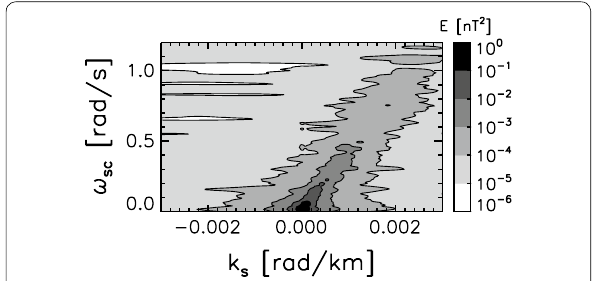
Fig. 4 Streamwise wavenumber–frequency spectrum for magnetic field fluctuations in the solar wind